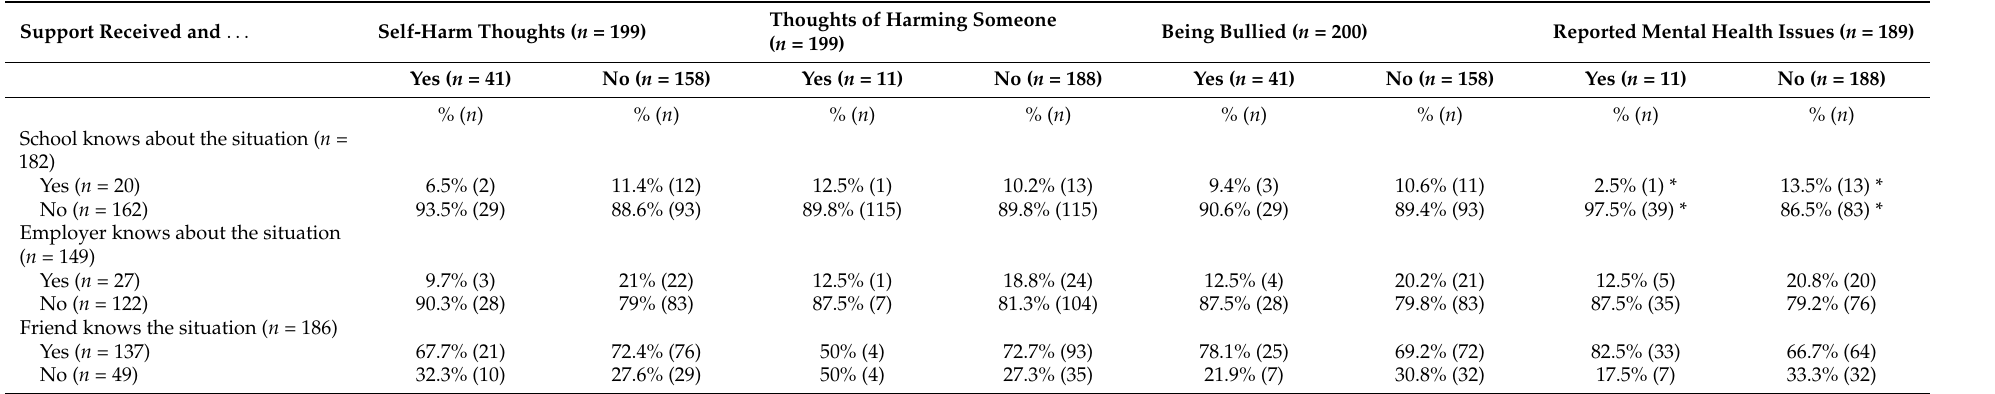
Table 6. Self-harm thoughts, thoughts of harming someone, being bullied, and reported mental health issues by visibility received. Support Received and . .